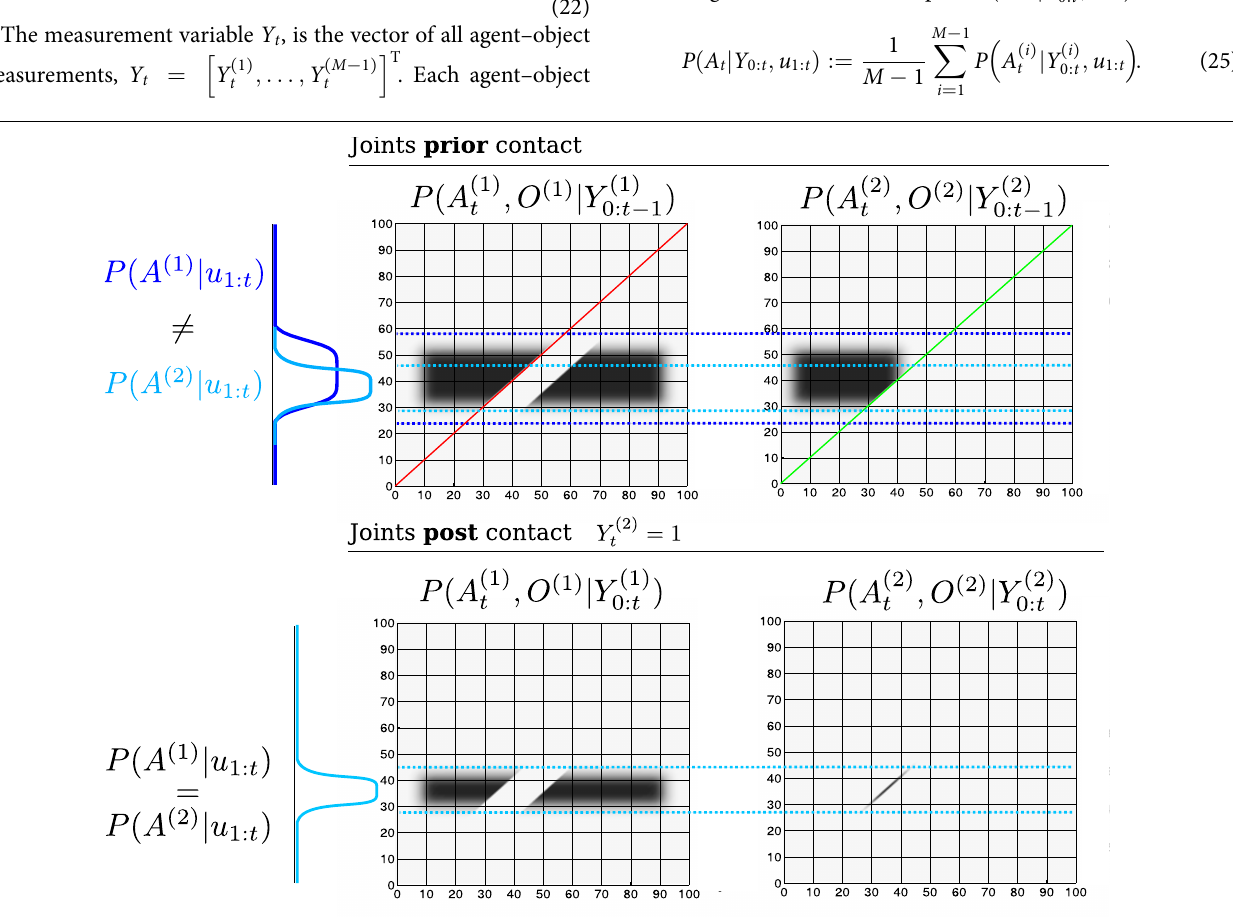
FIGURE 9 | Transfer of information (joint distributions). Top: joint distributions of P ( A ( 1 ) t , O ( 1 ) | Y ( 1 ) ) and P ( A ( 2 ) t , O ( 2 ) | Y ( 2 ) ) prior sensing, Y ( 2 ) t = 1, see Figure 10 ( Top right ) for the corresponding marginals. The red and green lines across the joint distributions correspond to the region in which the likelihood functions P ( Y ( 1 ) t | A ( 1 ) t , O ( 1 ) ) and P ( Y ( 2 ) t | A ( 2 ) t , O ( 2 ) ) will change the joint distributions. The dotted blue lines are to ease the comparison of the joint distributions prior and post sensing. Bottom right: After the agent has sensed O (2) , all the probability mass that was not overlapping the green line becomes an infeasible solution to the agent and object locations. At this point the marginals P ( A ( 1 ) t | u 1: t ) ̸ = P ( A ( 2 ) t | u 1: t ) are no longer equal (see the blue marginals Top ). Bottom left: The constraint imposed by the likelihood function of the second object (green line) is transferred to the joint distribution of the first object according to Algorithm A2 . This results in a change in the joint distribution P ( A ( 1 ) t , O ( 1 ) | Y ( 1 ) ) , which satisfies the constraints imposed by the agent’s marginal from the joint distribution P ( A ( 2 ) t , O ( 2 ) | Y ( 2 ) ) .